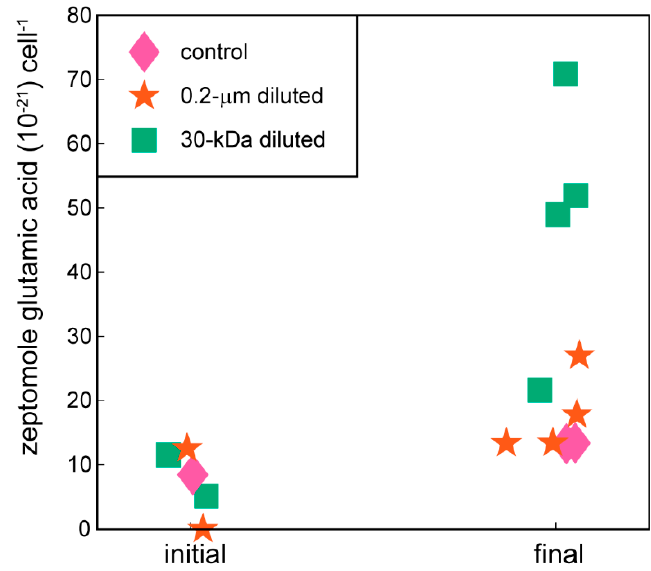
Figure 3. Cell-specific glutamic acid concentrations at the initial and final time points of experiment. Glutamic acid is one of the amino acids measured with the targeted metabolomics method used in this project. The remaining amino acids are plotted in Supplemental Figure